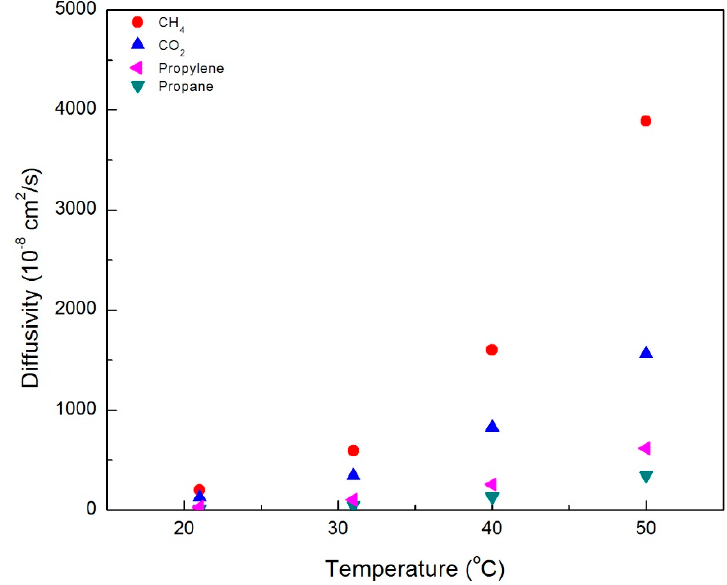
Figure A1. Schematic of the experimental apparatus used for permeation measurements.